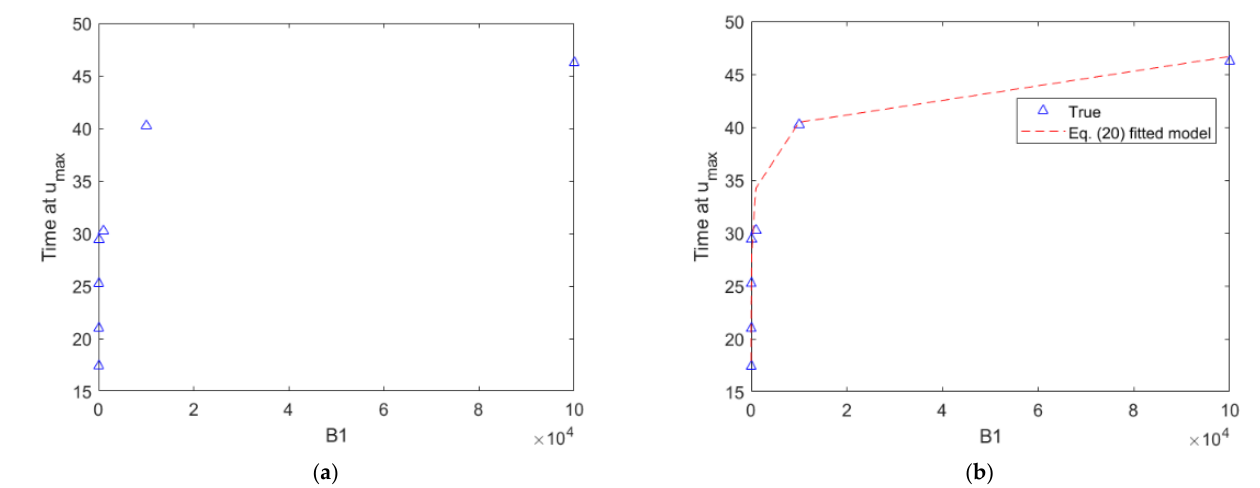
Figure 12. The t max time against parameters B 1 for the application of Policy 1. ( a ) The t max time against parameters B 1 ( b ) The t max time against parameters B 1 , versus the fitted model. For the case of Policy 2, the plot of t max against the parameters B 1 is plotted in Figure 13. This plot again suggests a logarithmic relationship in the form of Equation (18) for both control inputs u 1 and u 2 .